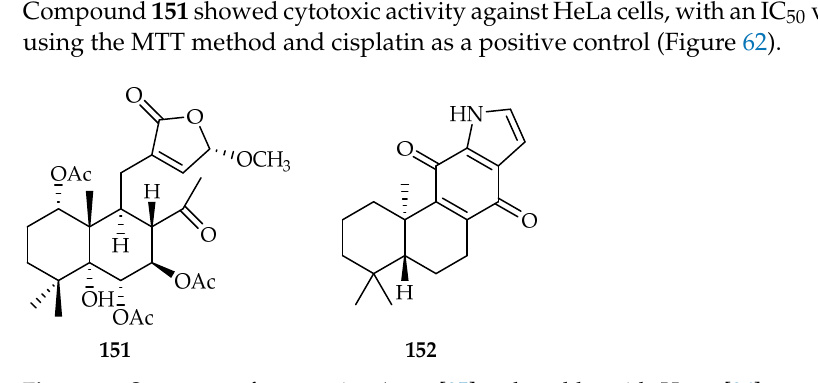
Figure 62. Structures of caesappine A 151 [95] and euphkanoids H 152 [96].